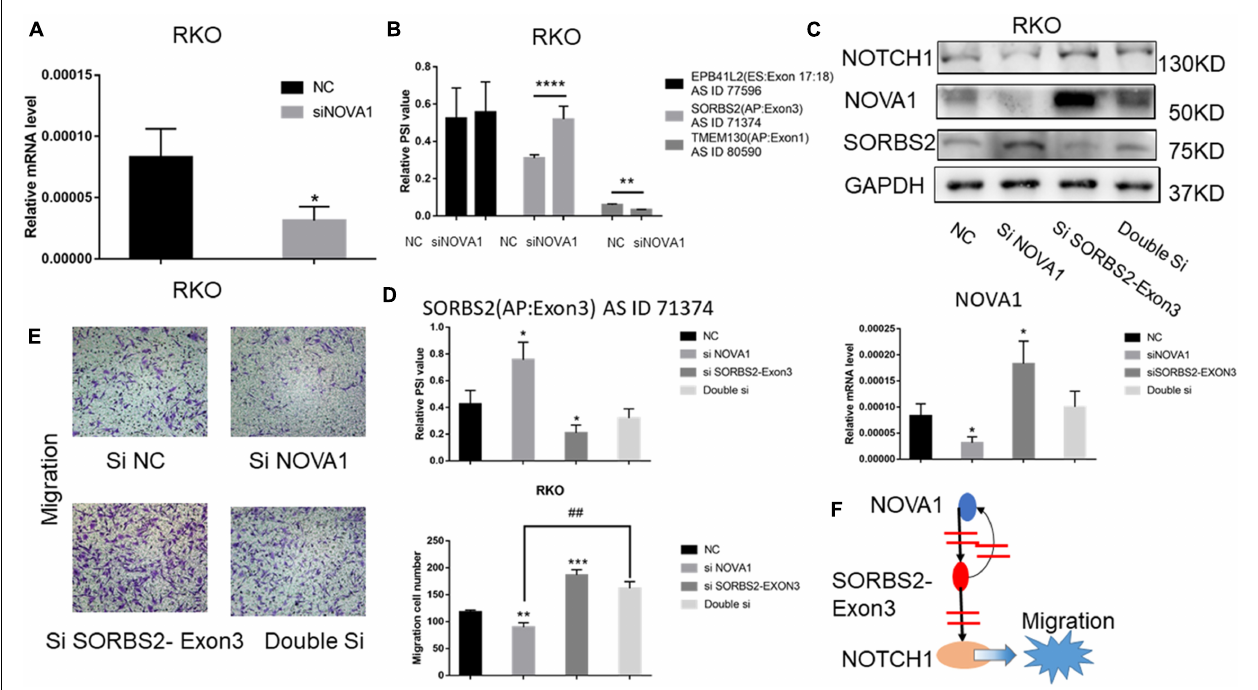
FIGURE 4 | The signal axis NOVA1/SORBS2/NOTCH1 regulates the migration of CRC. (A) The percent spliced-in (PSI) value of EPB41L2, TMEM130, and SORBS2 in the NC group and the siNOVA1 group. (B) qPCR was used to detect the expression of NOVA1 in the NC group and the siNOVA1 group. (C) RKO was transfected with the indicated si-RNA. After that, Western blot was used to detect the expression of NOVA1, NOTCH1, SORBS2, and GAPDH. (D) qPCR was used to calculate the PSI VALUE and NOVA1 of each group. (E) Transwell experiment showed the migration ability of each group. (F) NOVA1 inhibits the production of SORBS2 containing exon3 through variable splicing. SORBS2 containing exon3 not only reversely inhibits NOVA1 but also inhibits NOTCH1, thereby promoting the migration of CRC. Each experiment was representative of three independent experiments. “*” represents comparing with the control. * p < 0.05, ** p < 0.01, *** p < 0.001, and **** p < 0.0001, ## p <